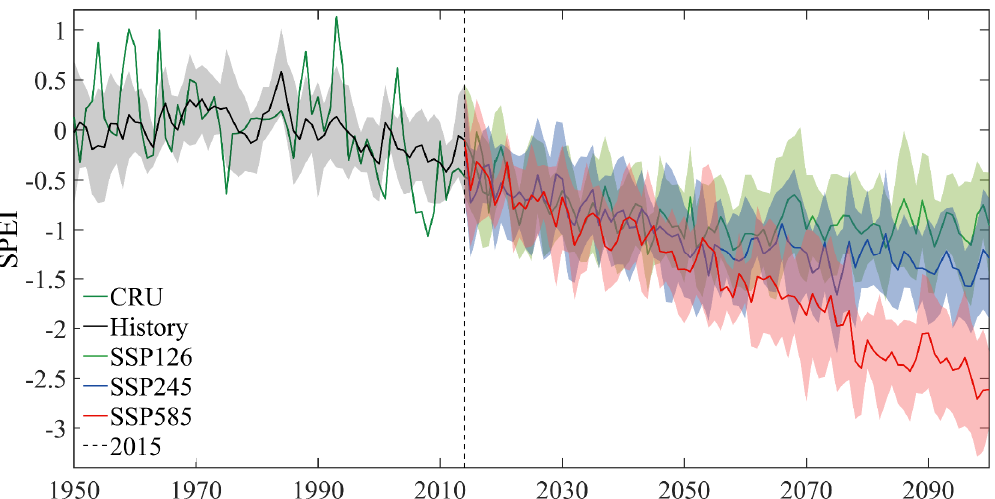
Figure 3. Temporal evolution of SPEI on a 12-month scale for the drylands of Asia and three future paths, which are SSP126, SSP245, and SSP585 (Averaged for the whole region). The colored lines represent the SPEI by ensemble means of GCMs in 2015–2100 under SSPs. The shadow represents the range of multiple GCMs. The black dashed line indicates the year 2015, allowing for a better comparison between historical and future periods.